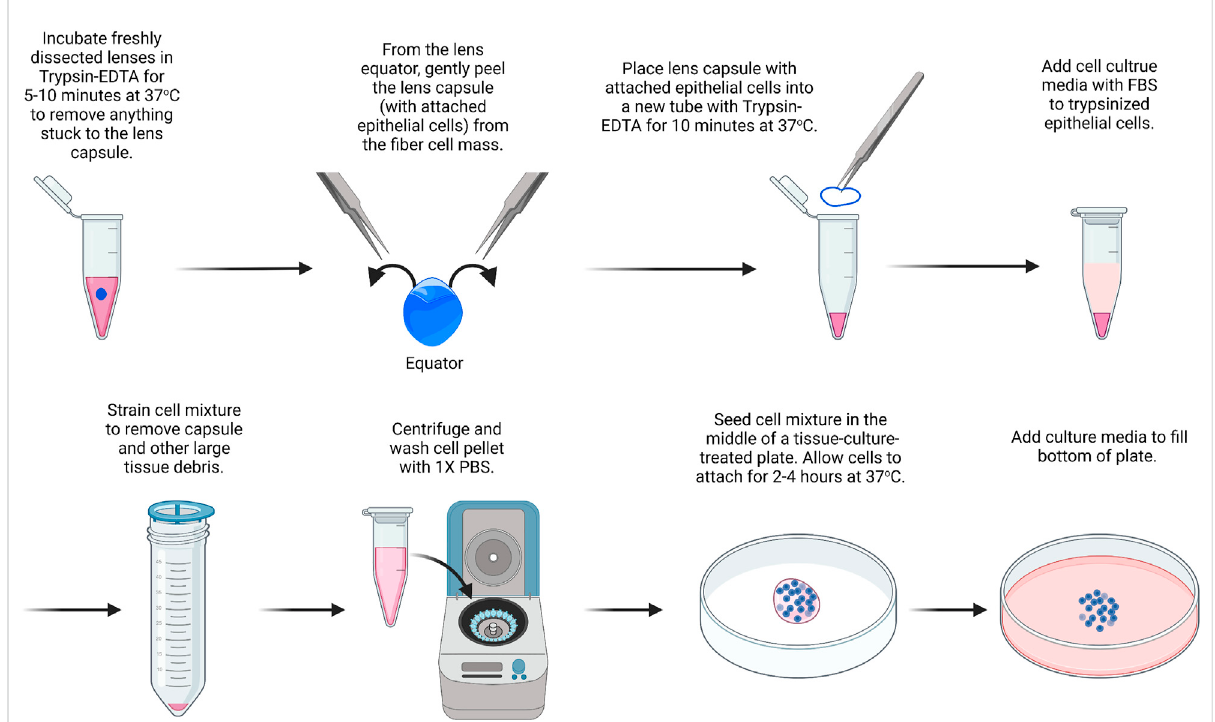
FIGURE 1 Primary lens epithelial cell isolation. Lenses are placed in trypsin/EDTA solution to remove extraneous materials that could stuck to the lenses duringdissection.Capsulesarethenisolatedandplacedintrypsin/EDTAtoliberate/dissociatecells.Cellsareseededontothecenterofaculturedish and fi lled with media after they attach. The image was drawn using Biorender and not drawn to scale.